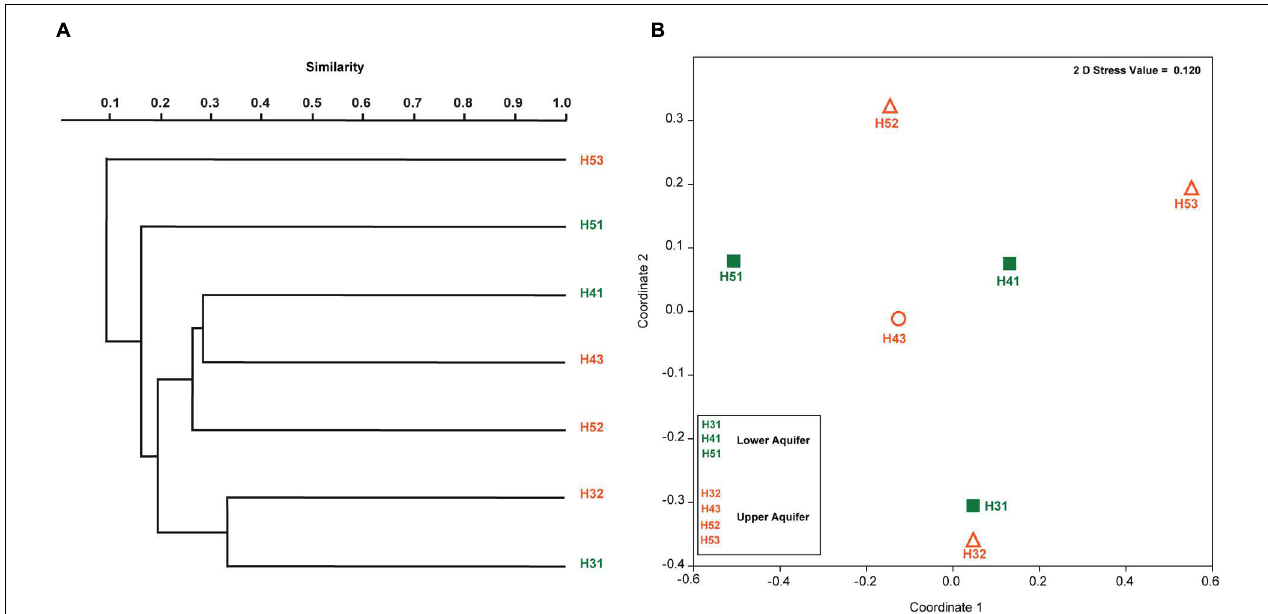
FIGURE 4 | Paired grouped (UPGMA) clustering of fungal OTUs found in the upper and lower aquifer assemblages in the Hainich CZE based on Bray–Curtis similarity index (A) and two-dimensional NMDS ordination of fungal community structures from upper and lower aquifers (B).